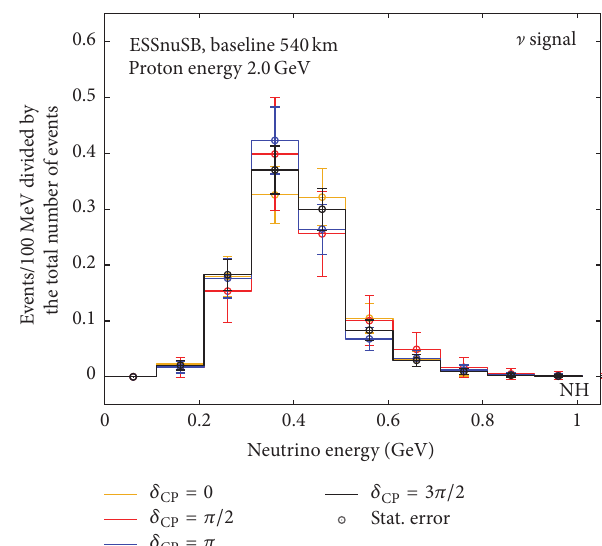
Figure 6: The 4 different histograms in this figure have been obtainedbydividingeachofthefourdifferenthistogramsinFigure3 by their respective total numbers of events, so that the difference in relative shape between the histograms can be